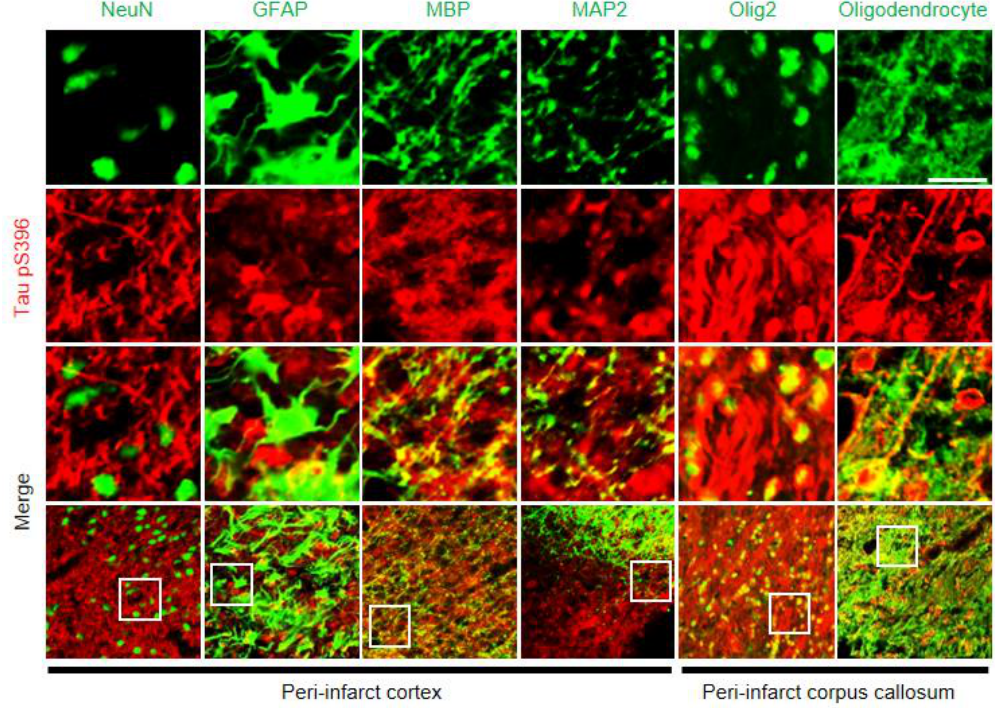
Figure 5. Histological correlation of tauopathy in the peri-infarct area of MB rats. Double-label immunohistochemistry of tau hyperphosphorylation at serine 396 residue (Tau pS396) and various markers, including NeuN, glial fibrillary acidic protein (GFAP), myelin basic protein (MBP), microtubule associated protein 2 (MAP2), Olig2, and Oligodendrocyte. Signals of NeuN, GFAP, MBP, and MAP2 were captured in the peri-infarct cortex and Olig2 and Oligodendrocyte in the peri-infarct corpus callosum. scale bar = 20 μm; MB, MCAO + BCCAo.